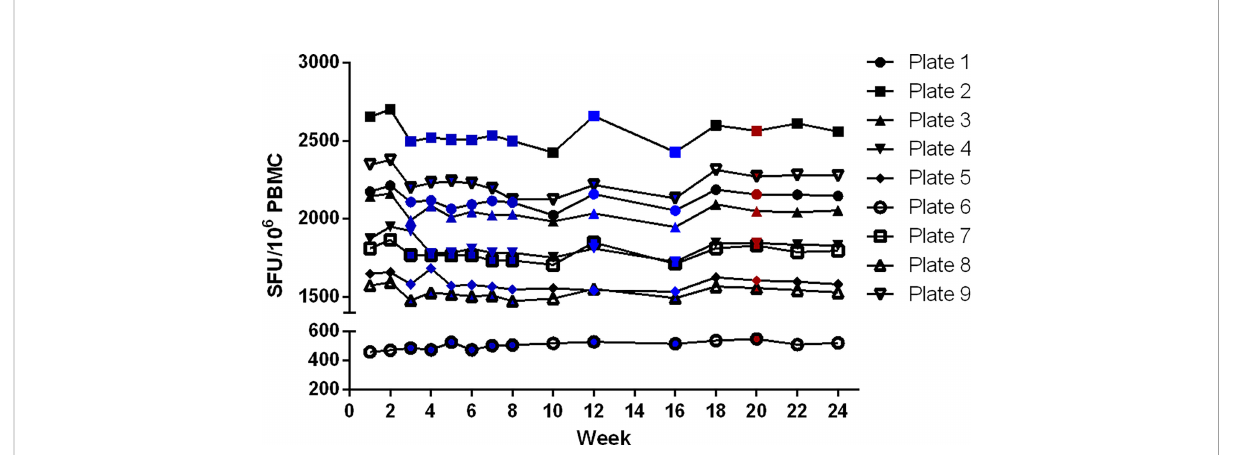
FIGURE 8 Determination of validity of signal stability over time. A set of 9 plates was re-read every other week for 24 weeks. The sum of all antigen- speci fi c IFN- g ELISpot responses of each plate was evaluated over time. Reading of the plates was performed by 3 different operators, indicated in black (n = 6), blue (n = 8) and red (n = 1).